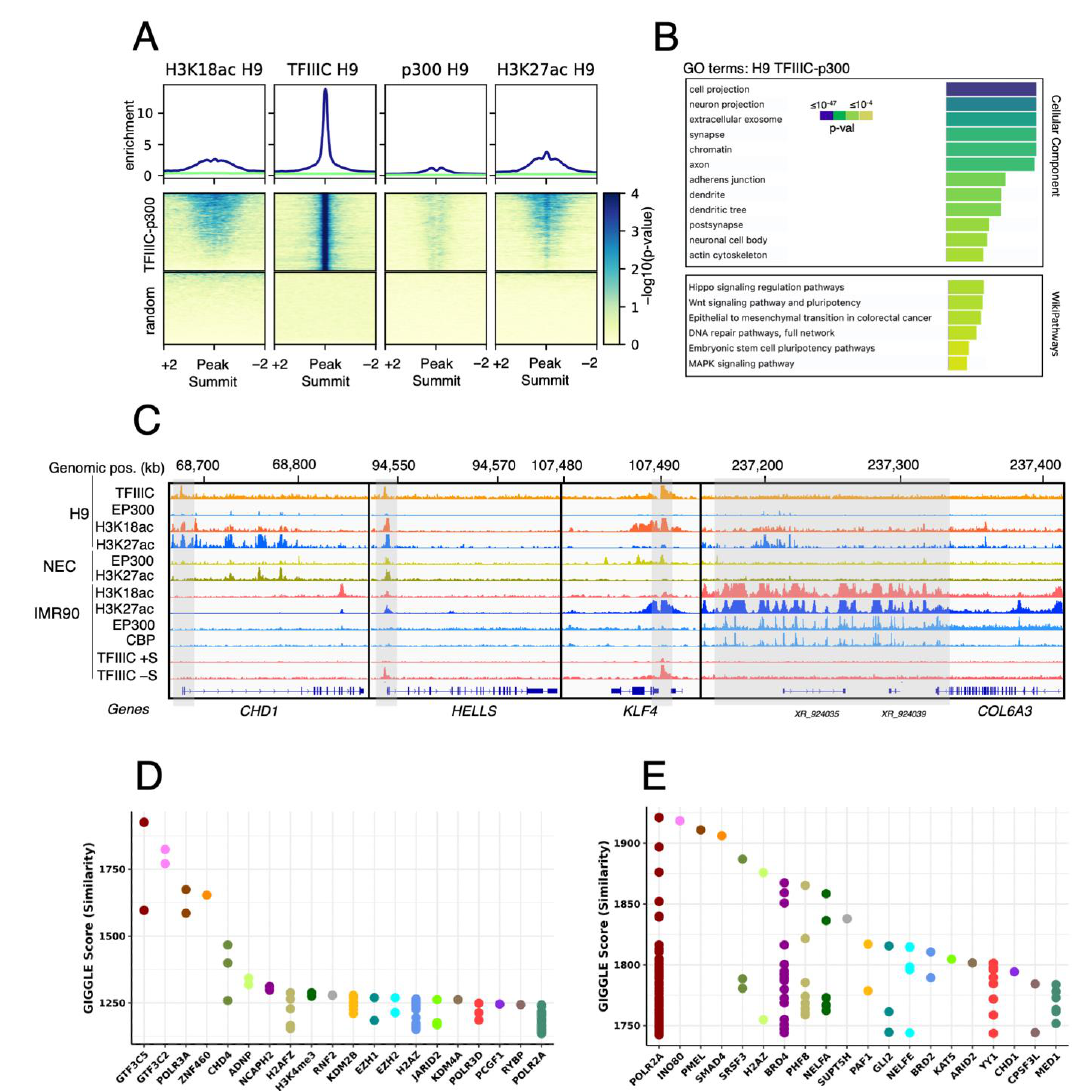
Figure 2. TFIIIC binds close to promoters of stem cells genes and neuronal genes. ( A ) Average levels and heatmap for H3K18ac, TFIIIC, p300 and H3K27ac in H9 hESCs. The panels on top of the heatmaps show the enrichment of the indicated factors at TFIIIC peaks, as seen in the corresponding heatmaps (medium panels). Note that H3K18ac and H3K27ac loci positive for TFIIIC are devoid of p300. The lower panels are heatmaps showing the enrichment of the indicated factors for a random set of peaks. ( B ) g:Profiler analysis [17] of TFIIIC peaks in H9 hESCs, showing GO terms enriched for cellular components and Wikipathways. The p -value for enrichment is shown as a color code. ( C ) Genome browser examples of H3K18as and H3K27ac peaks in H9 hESCs, NECs and IMR90 fibroblasts: stem cell-associated genes such as CHD1 , HELLS , KLF4 and the fibroblast-expressed marker COL6A3 gene are shown. These stem cell loci are devoid of p300 but associated with TFIIIC in H9 hESCs (the grey bars indicate TFIIIC peaks within the promoter regions of these genes). In contrast, COL6A3 is associated with p300/CBP in IMR90 cells. At the promoters of KLF4 and HELLS , the TFIIIC peaks are also visible in serum-starved IMR90 cells (–S). ( D , E ) GIGGLE score analysis for all TFIIIC peaks ( D ) and TFIIIC peaks overlapping H3K18ac peaks (E) in hESCs